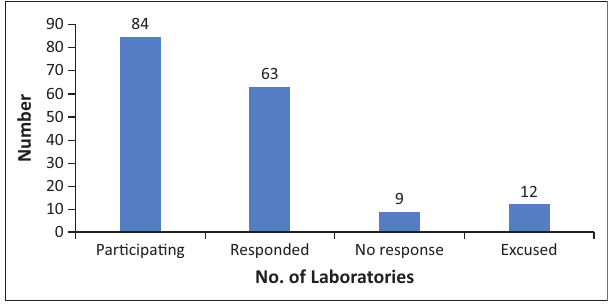
FIGURE 3: Responses from Pima CD4 sites participating in Oneworld Accuracy test in 2015 (event